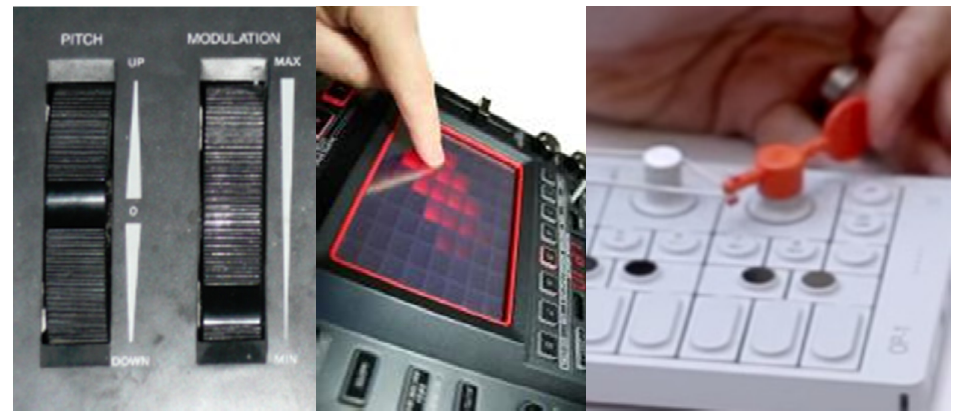
Figure 6. Modulation wheels ( left ); Korg Kaoss Pad; ( center ) and bender on the Teenage Engineering OP-1 ( right